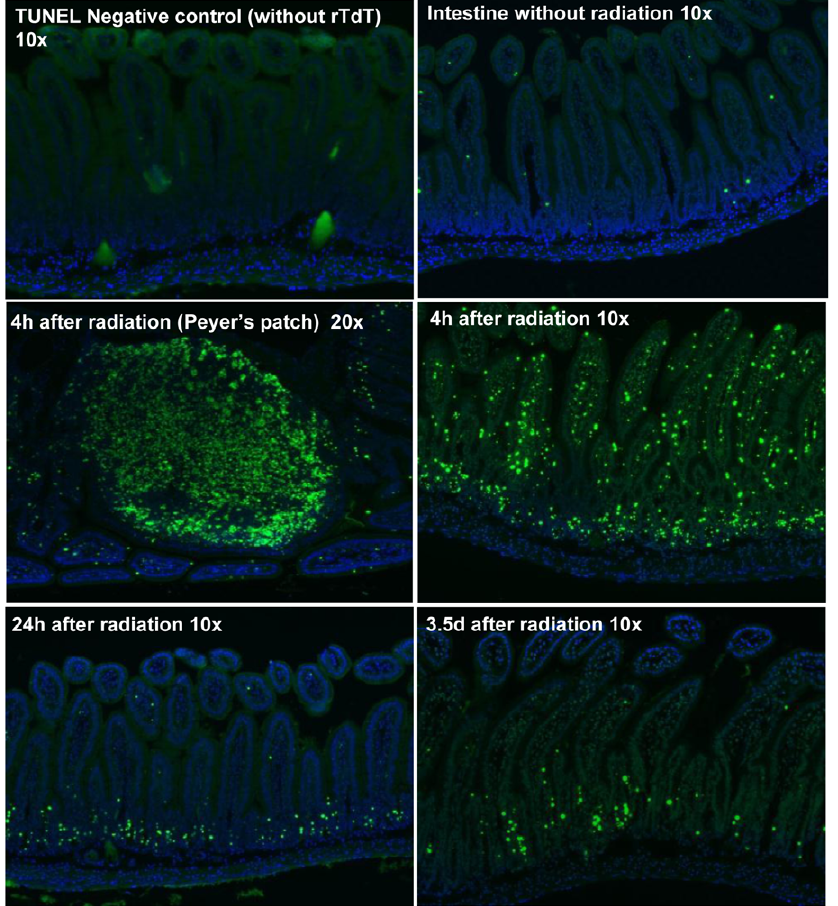
Figure 2. DNA damage in mouse small intestine at baseline and different time points. TUNEL staining to demonstrate DNA damage in mouse small intestine at baseline and 4 h, 24 h, and 3.5 d after irradiation. Green: TUNEL positive, Blue: DAPI. 10 6 /20 6 : the magnifying power of the objectives. rTdT: recombinant Terminal Deoxynucleotidyl Transferase enzyme.